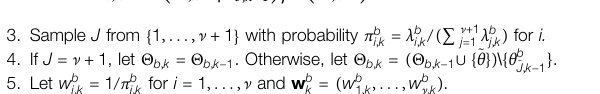
Algorithm 3 | Updating procedure SS ( Θ b , k , w b k ) for MCMC-SS 1. Sample ~ θ from q (· 2. Let θ b ] + 1 , k − 1 (cid:1) ~ θ and